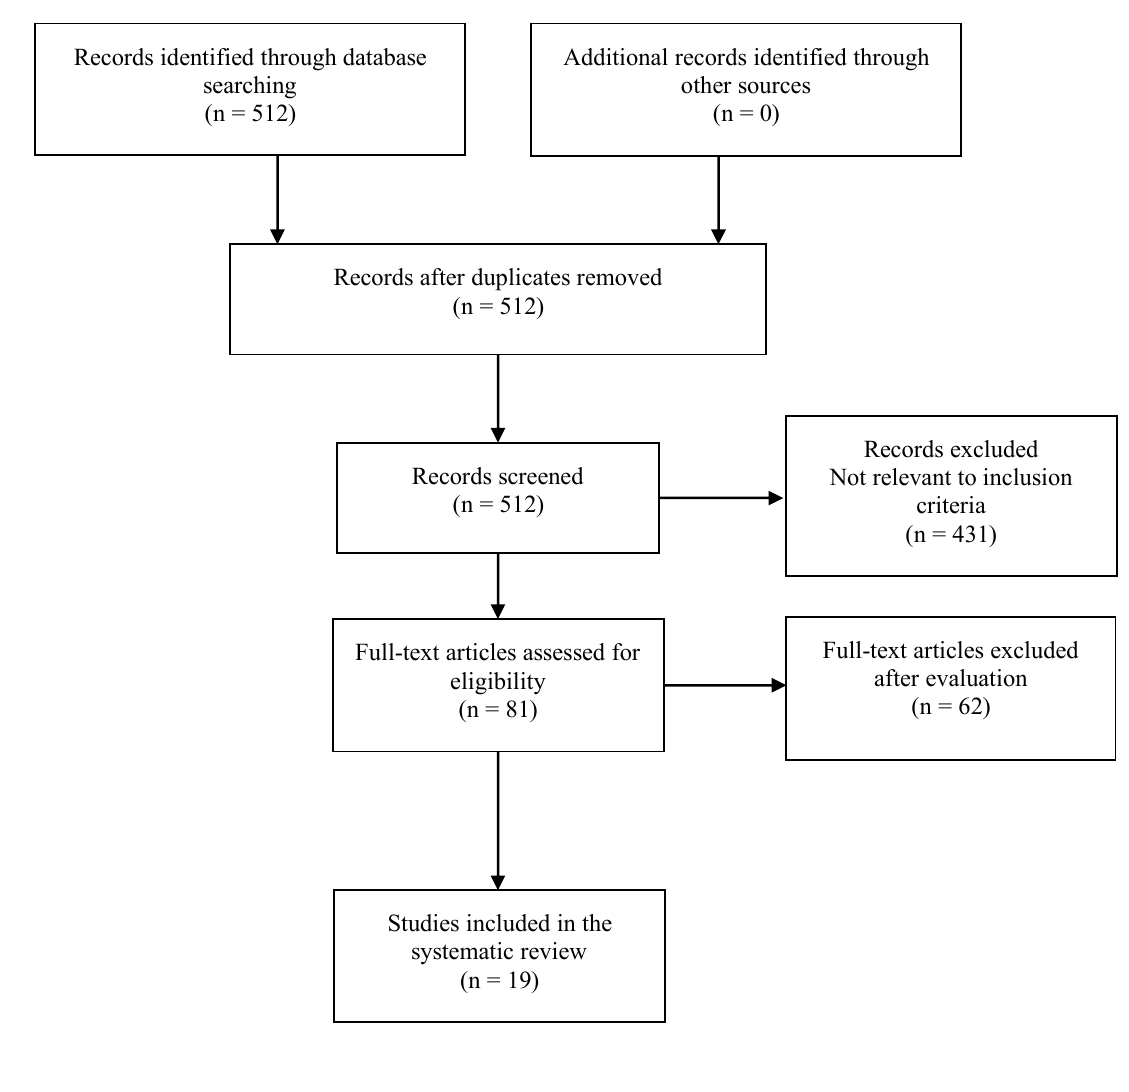
Figure 1. Flowchart of inclusion of studies in the systematic review.